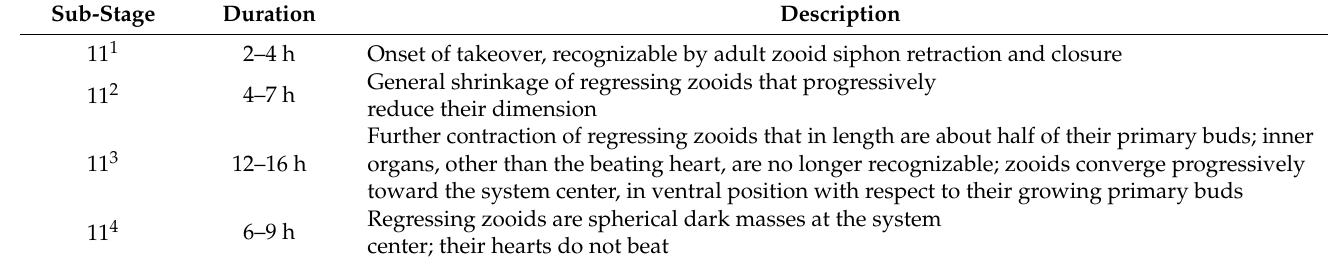
Table 1. Description of main takeover events, which last about 48 h and repeat every week at 18 ◦ C [44,48]).